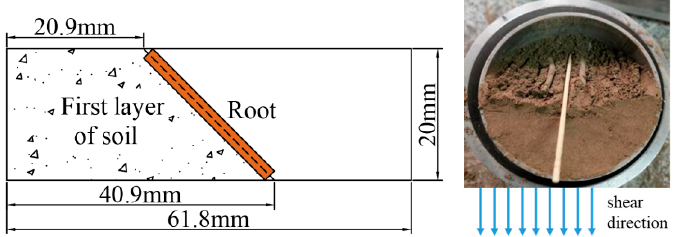
Figure 12. Preparation of root-permeated soil sample with δ of 90° (RAR0.21% as an example).